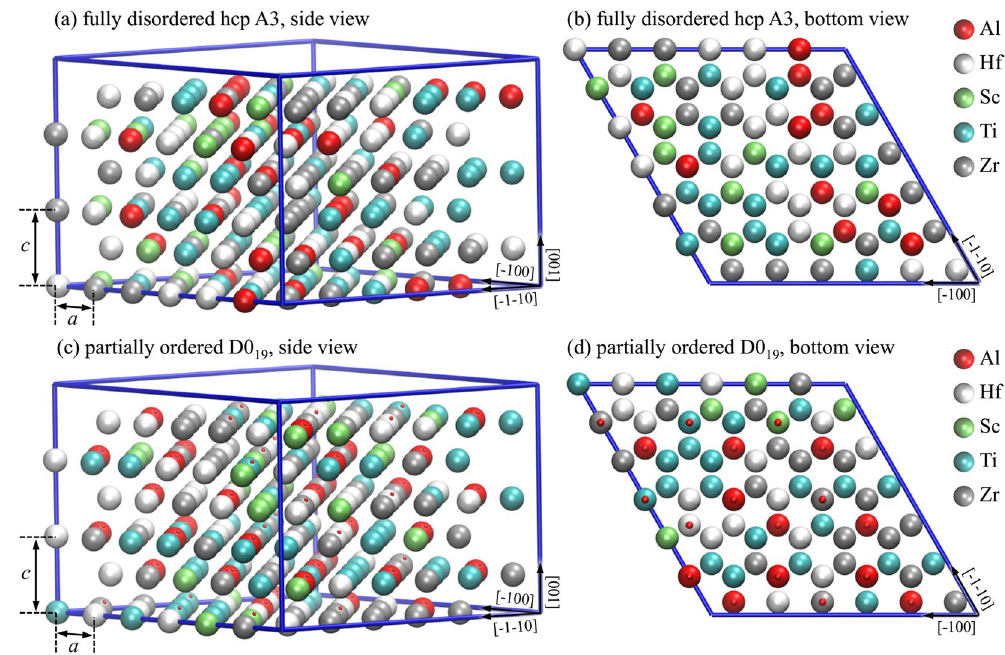
Figure 3. Side and bottom view of the 216-atom super cells of the disordered hcp A3 structure [( a ) and ( b )] as well as for the partially ordered D0 19 structure [( c ) and ( d )] employed in the first-principles calculations for Al 15 Hf 25 Sc 10 Ti 25 Zr 25 at.%. The small red dots in ( c ) and ( d ) indicate the sublattice positions for the ordered Al atoms in the D0 19